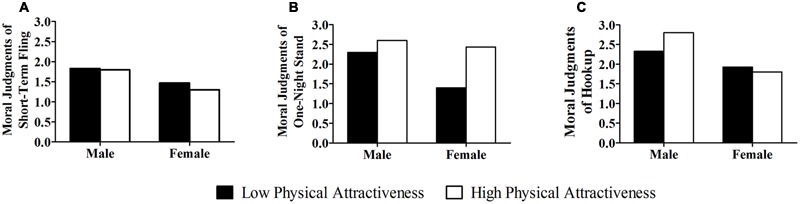
Mean moral judgments on (A) short-term fling, (B) one-night stand, and (C) hookup as a function of gender and physical attractiveness.